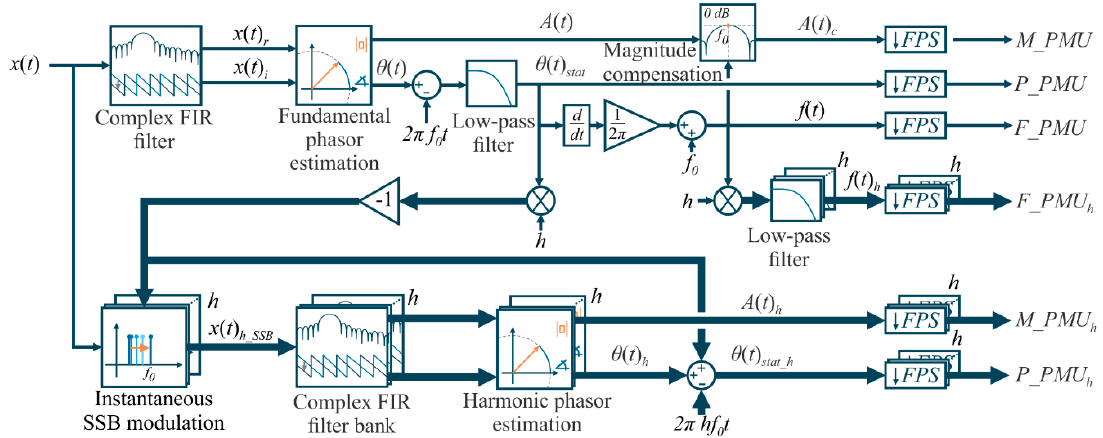
Figure 1. Proposed methodology for estimation of harmonic phasors.